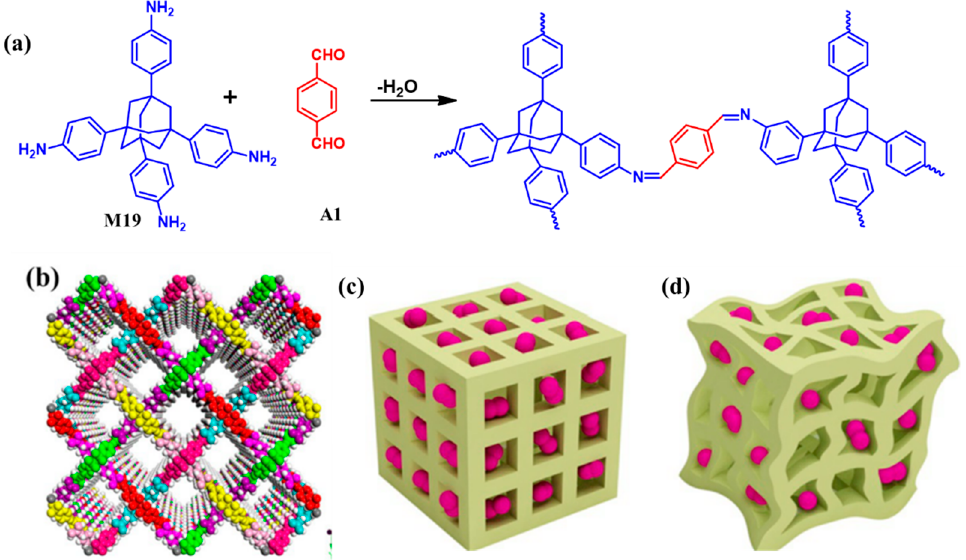
Figure 9. ( a ) Synthesis of COF-DL229. ( b ) Structural representations of eightfold interpenetrated dia network of 3D COF-DL229. Schematic representation of plausible iodine adsorption behavior in the ordered COFs ( c ) and the deformed porous materials ( d ). Reprinted/adapted with permission from Ref. [67]. Copyright (2018), John Wiley and Sons.